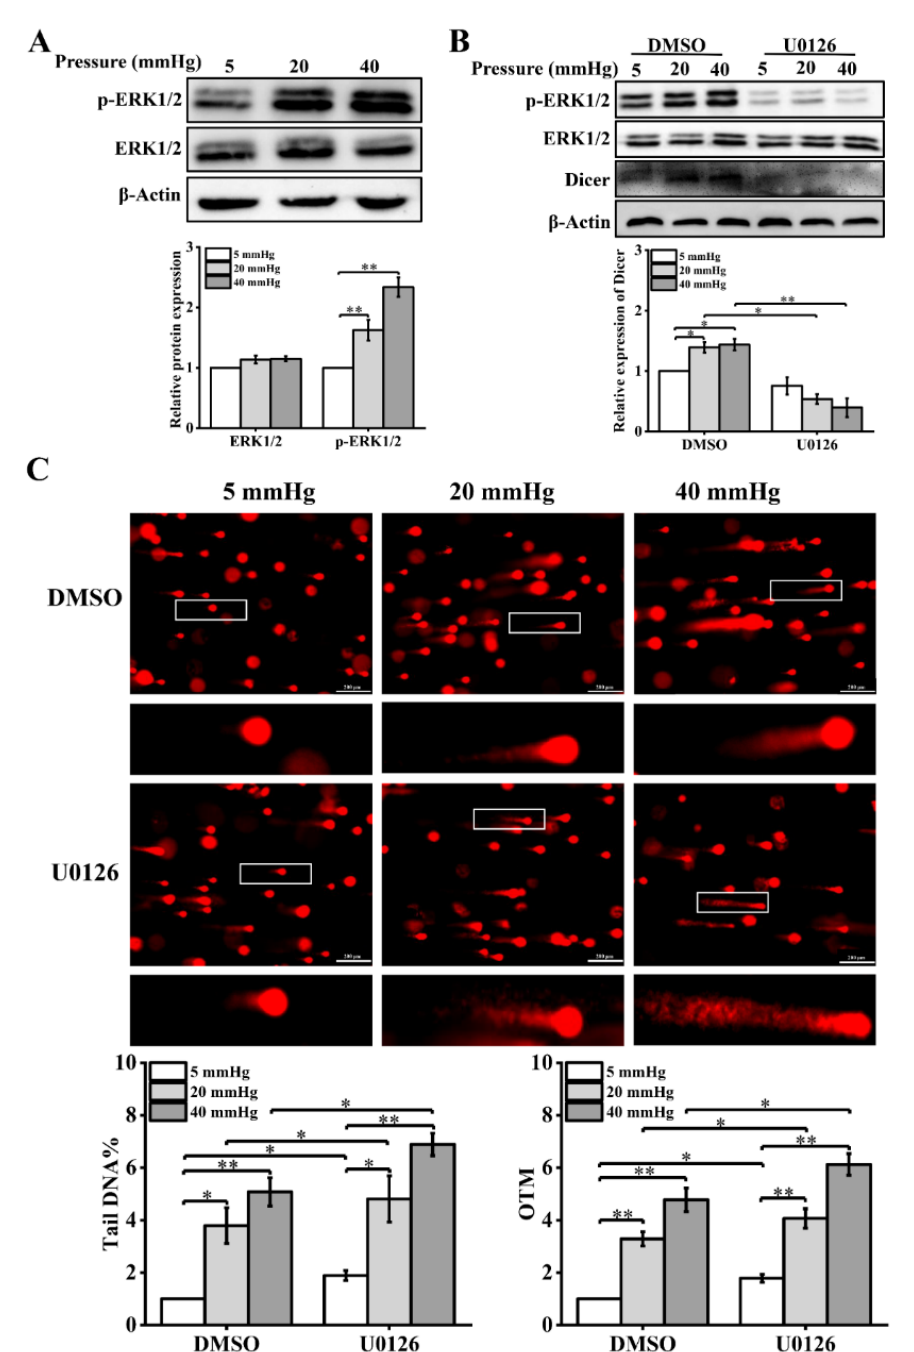
Figure 5. Pressure activates ERK1/2, and U0126 treatment leads to increased DNA damage in hepatocytes under pressure: ( A ) Western blots showing the protein levels of p-ERK1/2 and ERK1/2 in hepatocytes treated with pressure for 48 h. Histogram showing the mean level of total ERK1/2 and ERK1/2 activation (p-ERK1/2/total ERK1/2); ( B ) Western blots show the protein levels of p-ERK1/2, ERK1/2, and Dicer in hepatocytes treated with U0126 (10 µM). Histogram shows mean level of Dicer expression from three independent experiments; ( C ) DNA damage in U0126-treated hepatocytes cultured for 48 h under different pressure levels (5, 20, 40 mmHg) was examined with the comet assay. OTM and tail DNA% were used to calculate the degree of DNA damage (scale bar, 200 µm). Data are expressed as the mean ± SD. n = 3, * p < 0.05, ** p < 0.01.